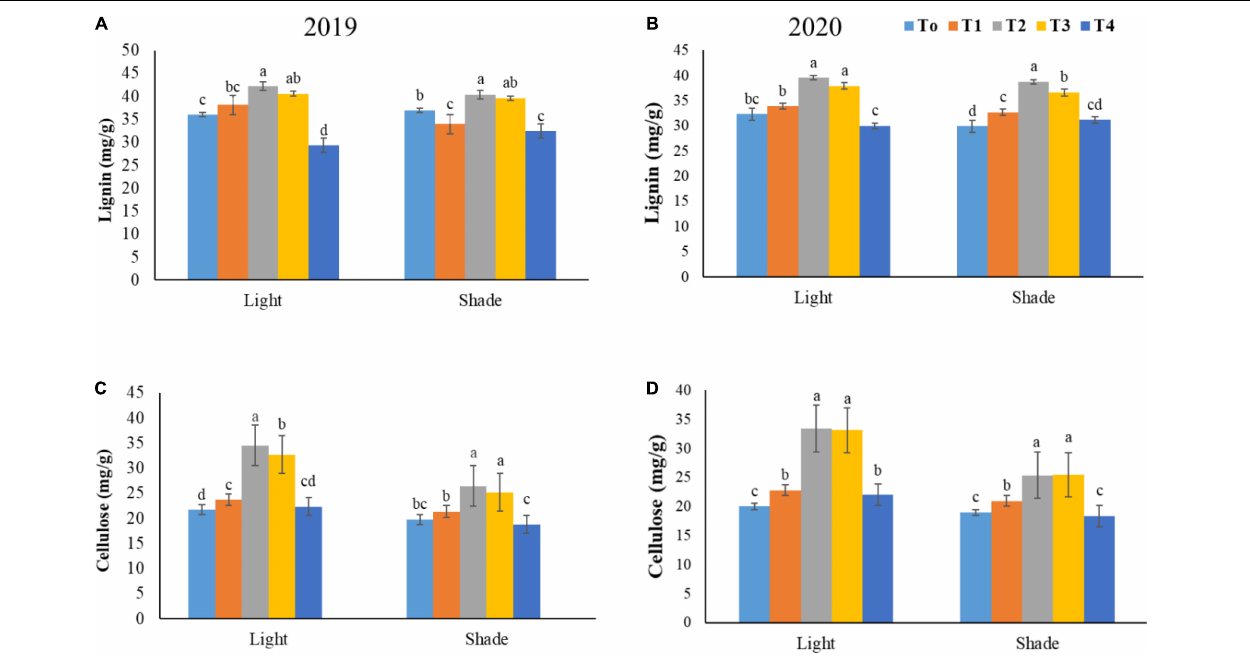
FIGURE 5 | Effect of various NH 4 + /NO 3 − ratios on lignin content (A,B) , and cellulose content (C,D) under light and shade. Different treatment levels T0, T1, T2, T3, and T4 characterize the ratios of NH 4 + /NO 3 − 0/0, 0/100, 25/75, 50/50, and 75/25, respectively. All of the results are the mean of three replications. The bars represent the ± SD (standard deviation). A significant difference ( ∗ p < 0.05) between treatments is shown by different lowercase letters above bars.